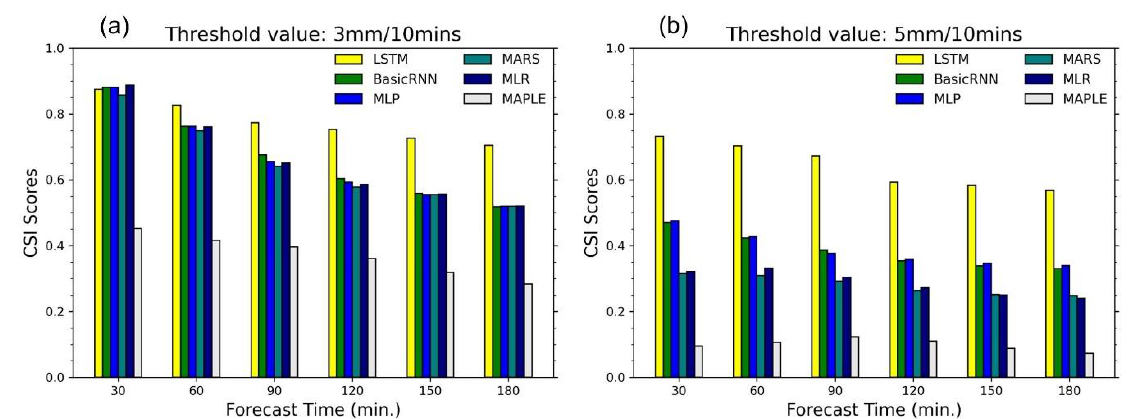
Figure 9. Critical success index ( CSI ) scores of the data-driven models and the MAPLE system with two thresholds in the five events. ( a ): CSI scores with 3 mm/10 min threshold; ( b ): CSI scores with 5 mm/10 min threshold.